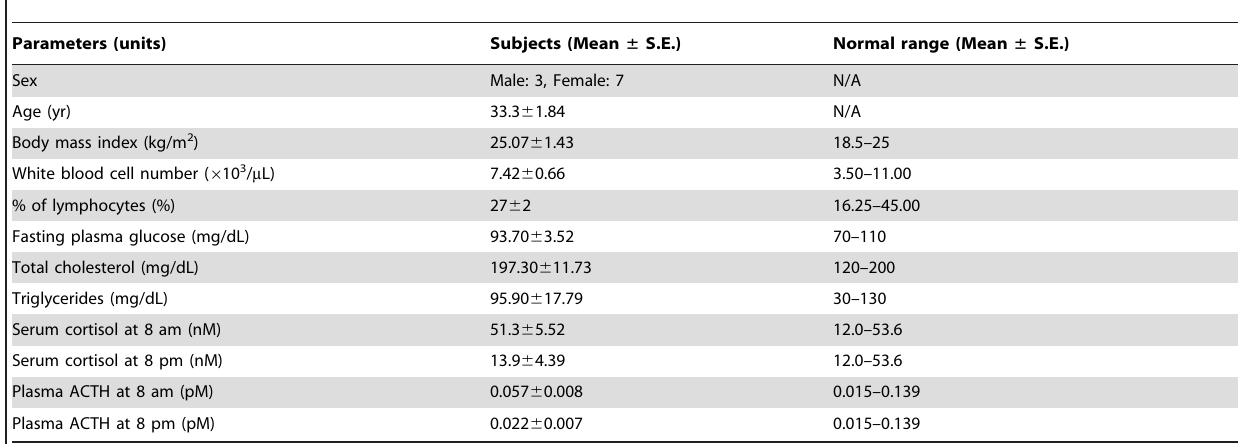
Table 1. Clinical characteristics and endocrine parameters of the subjects enrolled in the study.